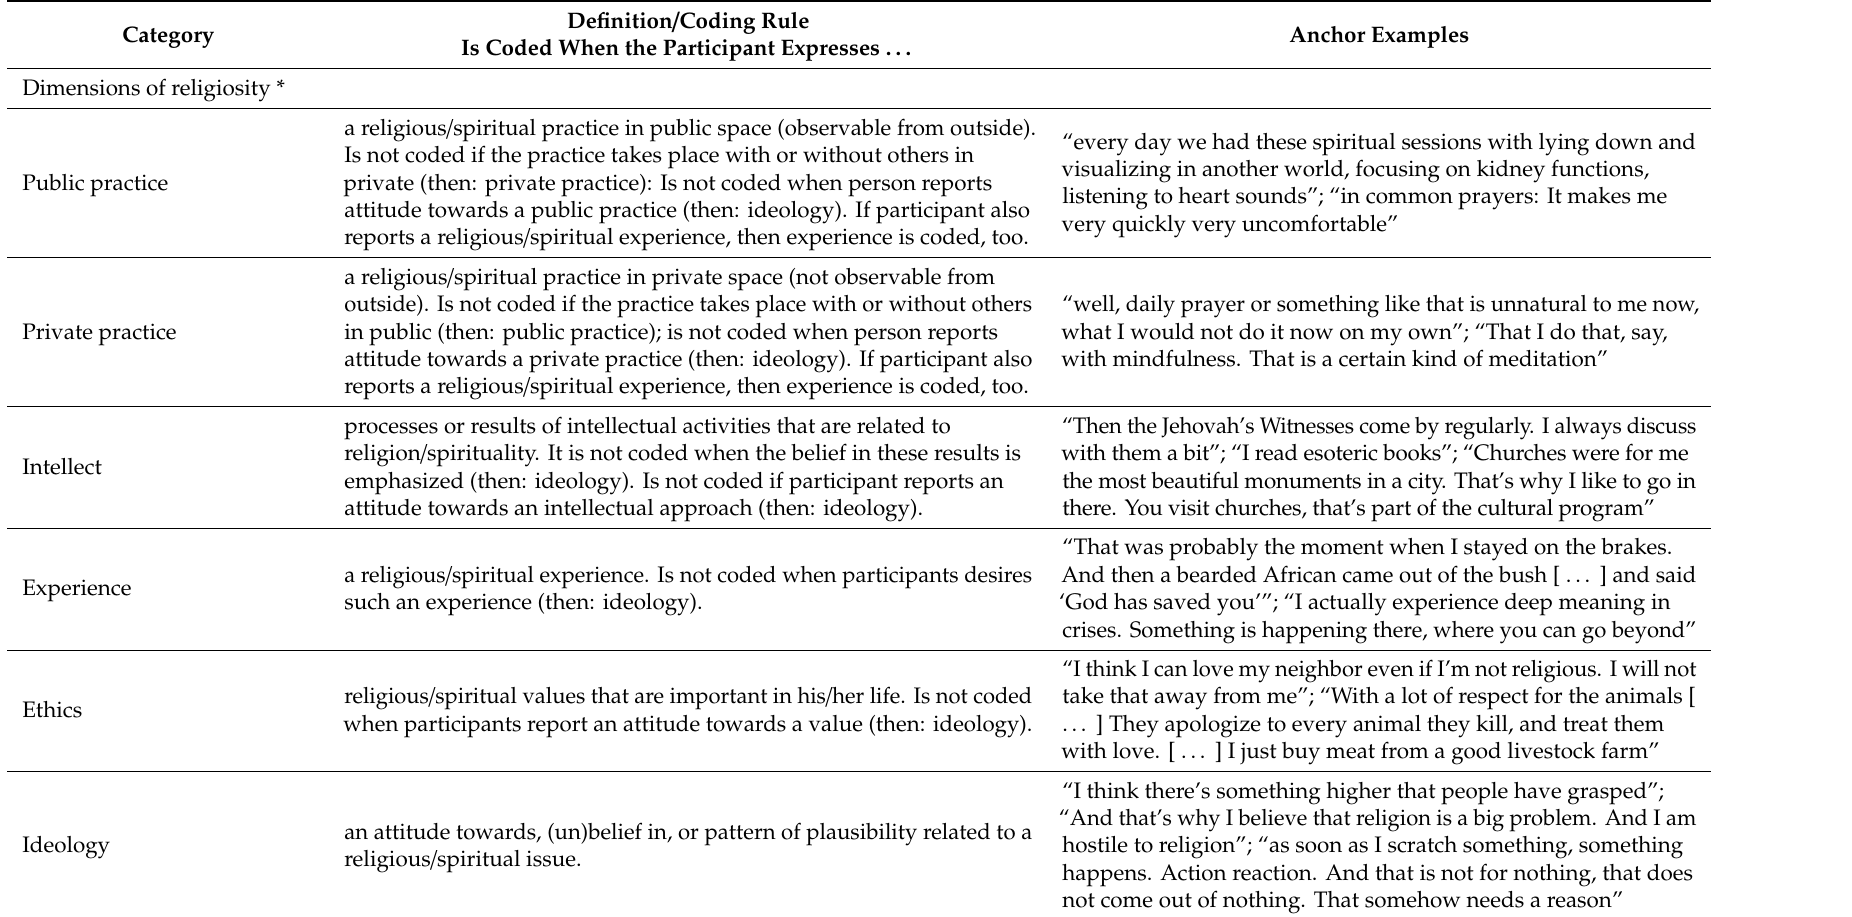
Table A1. Coding guideline: Deduced categories of analysis, definitions, and anchor